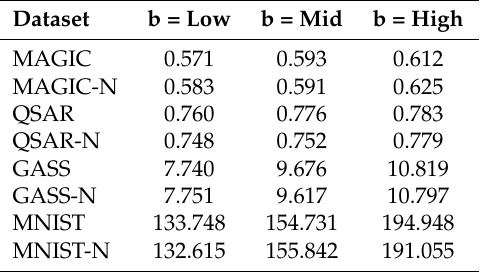
Table 4. Average execution times.